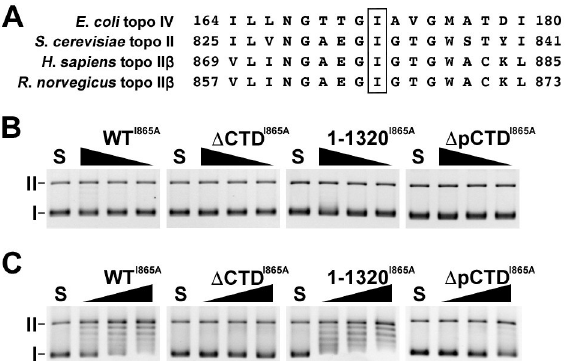
Fig 4. The pCTD of rat topo II β maintains the relaxation activity of I865A mutants. (A) Amino acid sequence alignment of E . coli topo IV ParC subunit (164–180), S. cerevisiae topo II (825–841), H. sapiens topo II β (869–885) and R. norvegicus topo II β (857–873). Box represents the conserved isoleucine (I). (B) Relaxation assays were performed using 50 ng pUC18 and purified FLAG-tagged I865A mutants (100, 50, and 25 fmol). The DNA bands were detected by GelRed staining. (C) Relaxation assays were performed using 5 ng pUC18 and purified FLAG-tagged I865A mutants (50, 100, and 200 fmol). The DNA bands were detected by SYBR Green I. I: supercoiled DNA. II: nicked circular